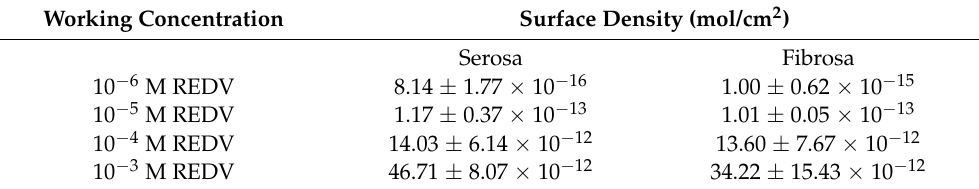
Table 1. Working REDV concentration and effective REDV surface densities on DBP. Working